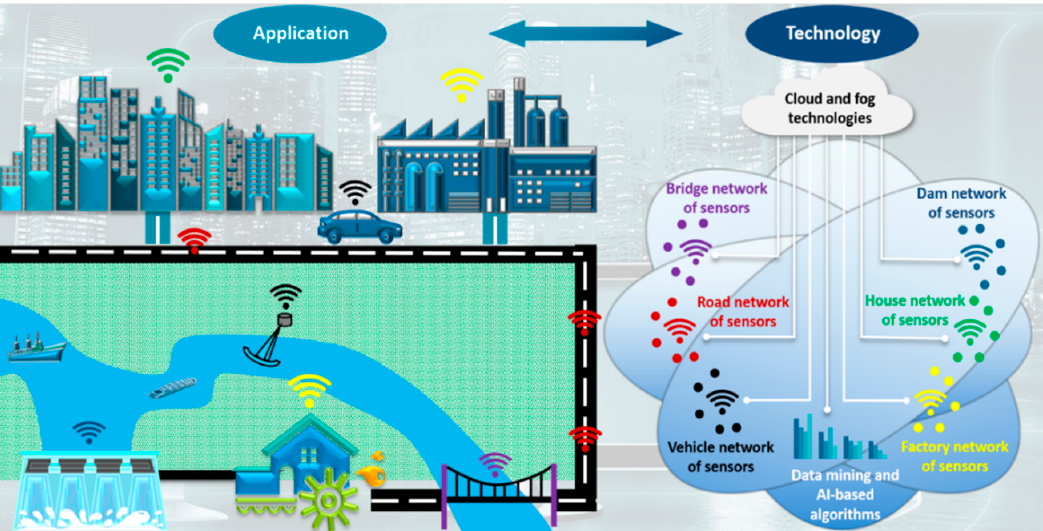
Figure 7. A vision for next-generation smart and connected civil infrastructure platform integrating advanced SHM, information, and data mining technologies.